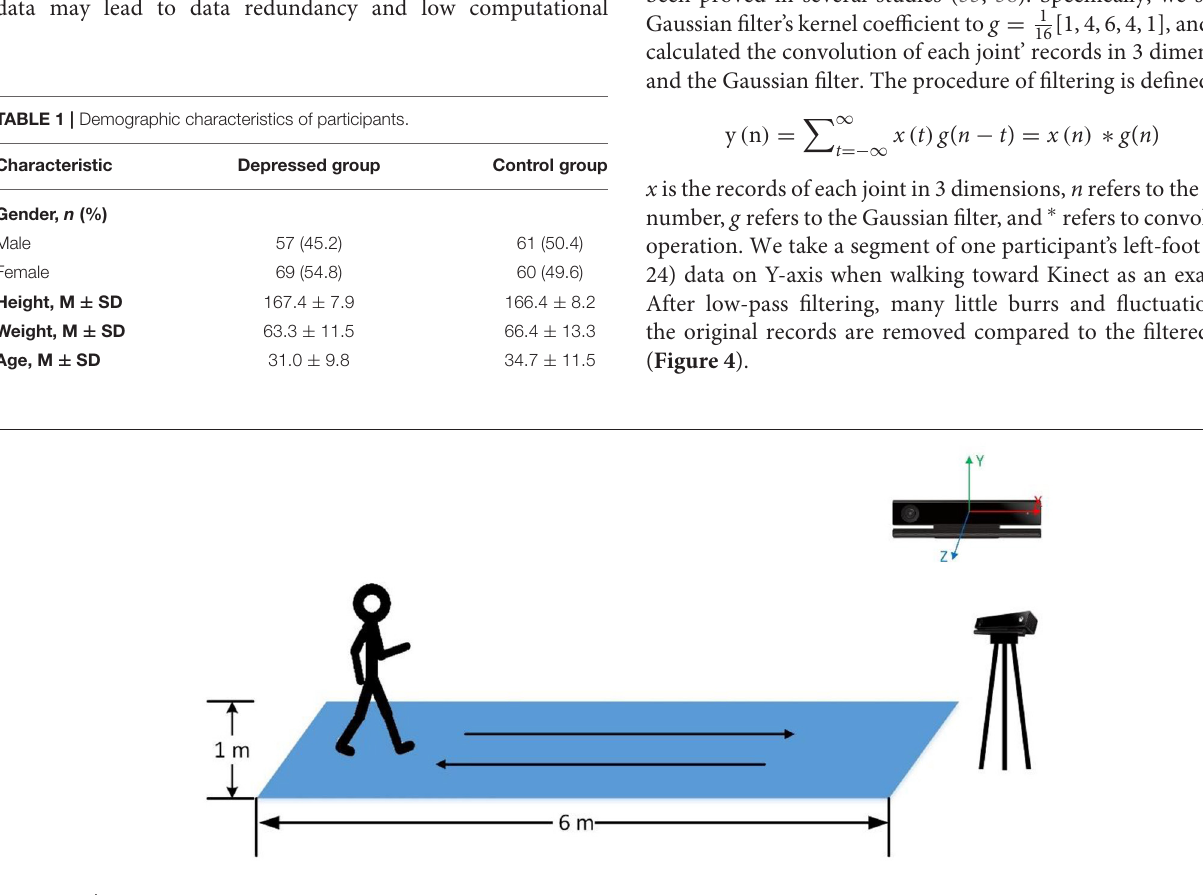
FIGURE 1 | The schematic of the experiment